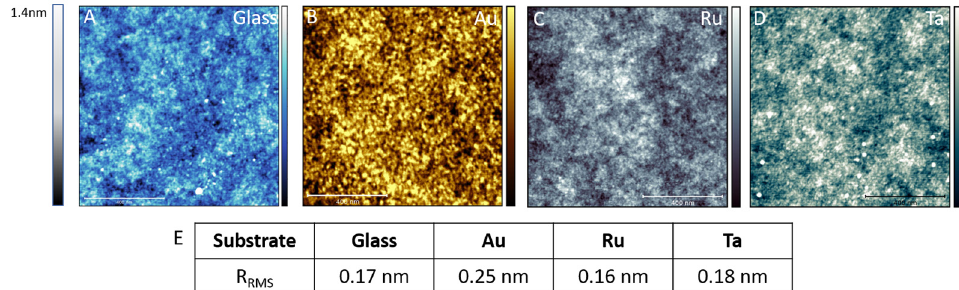
Figure 3. Analysis of surface roughness by atomic force microscopy of four different surfaces. As a control surface we used glass slides ( A ). Different metal coatings are shown in ( B – D ). ( B ) gold, ( C ) ruthenium and ( D ) tantalum. The scale bars in the images are 400 nm and the z height is 1.4 nm. In ( E ) the root mean square roughness for the different surfaces is shown.